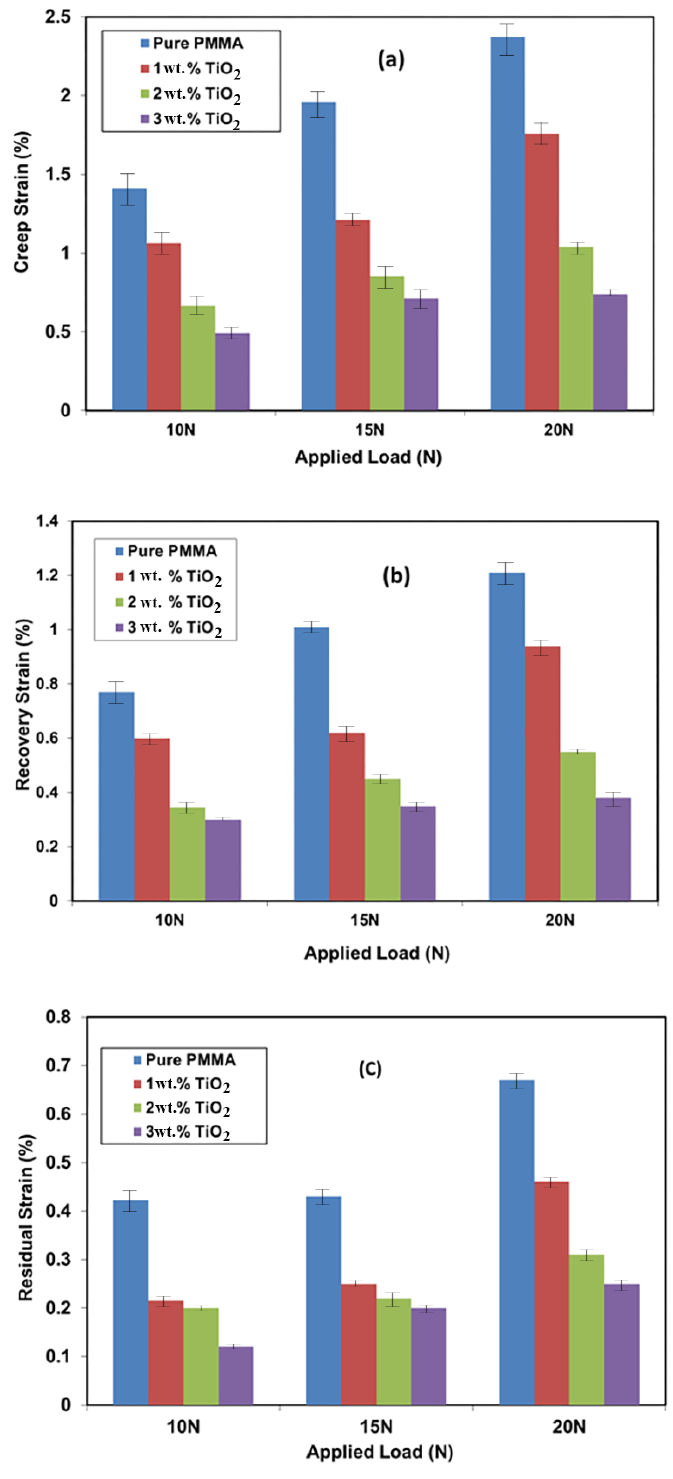
Figure 6. ( a ) Creep, ( b ) recovery and ( c ) residual strain of PMMA and its nanocomposites at different